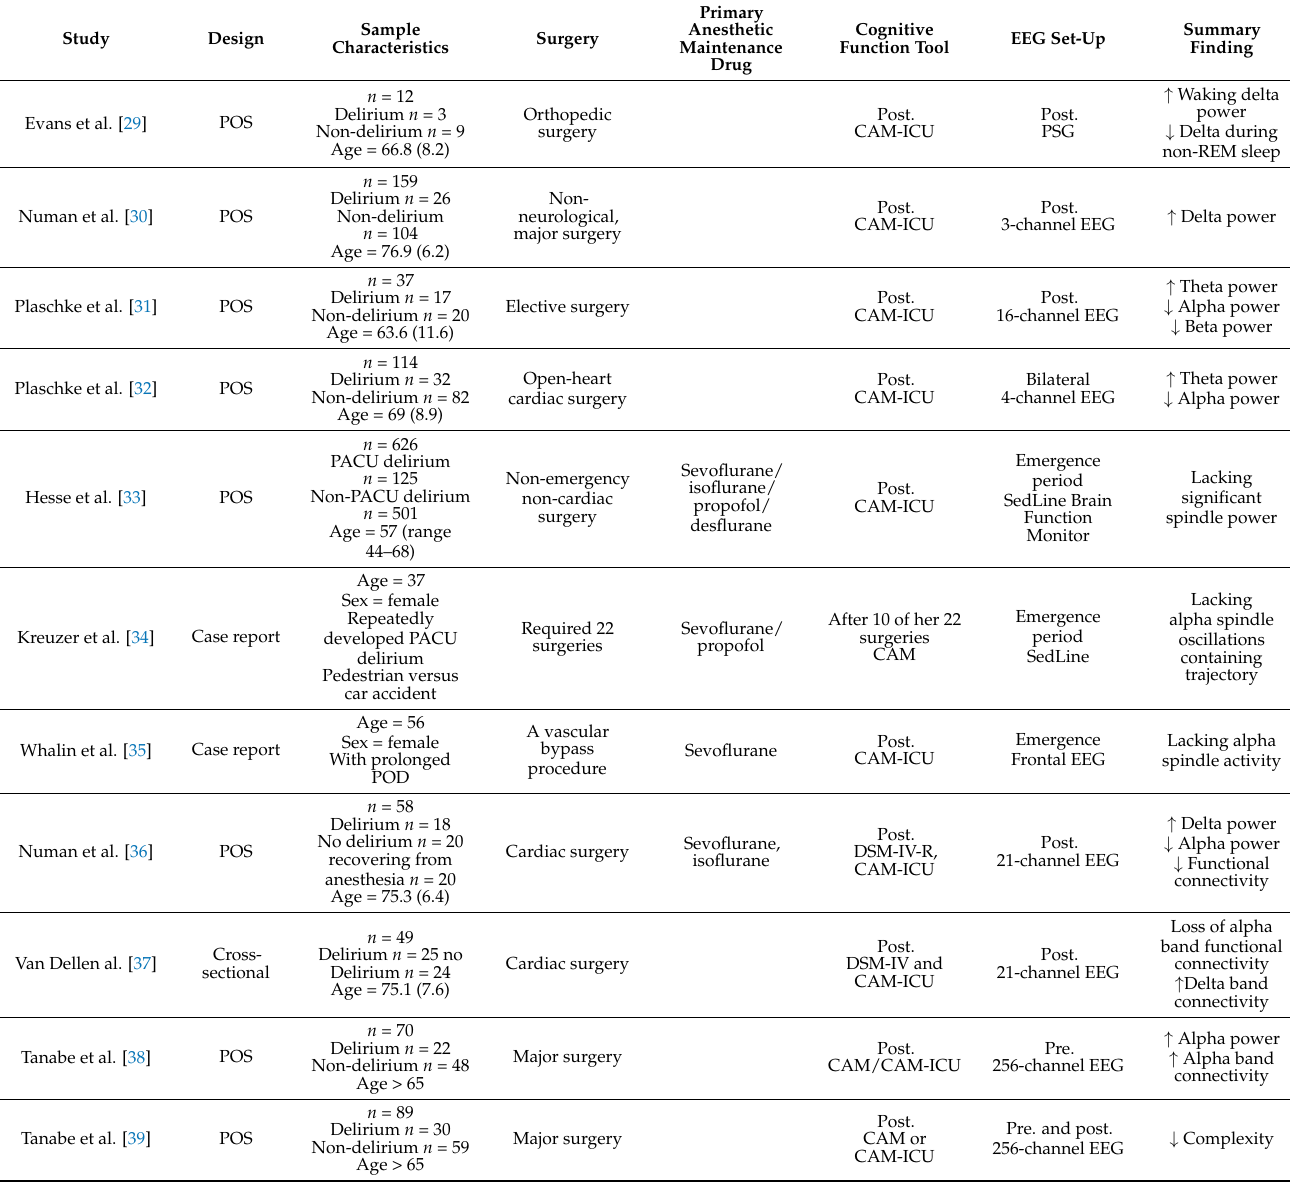
Table 2. Studies about postoperative EEG features related to